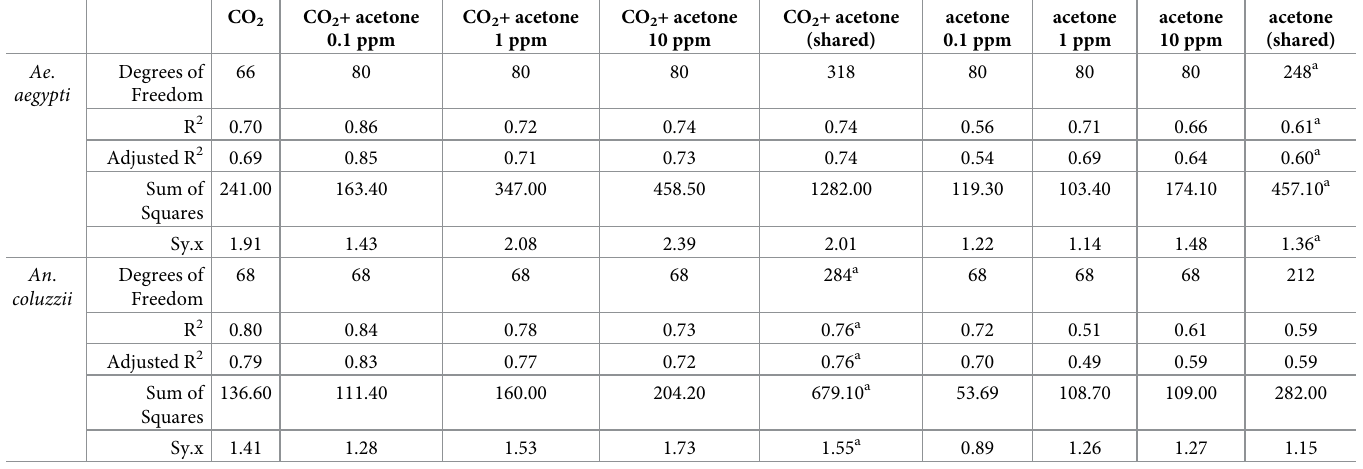
Table 1. The goodness of fit for the non-linear regressions in Fig 3C and 3D. CO 2 CO 2 + acetone 0.1